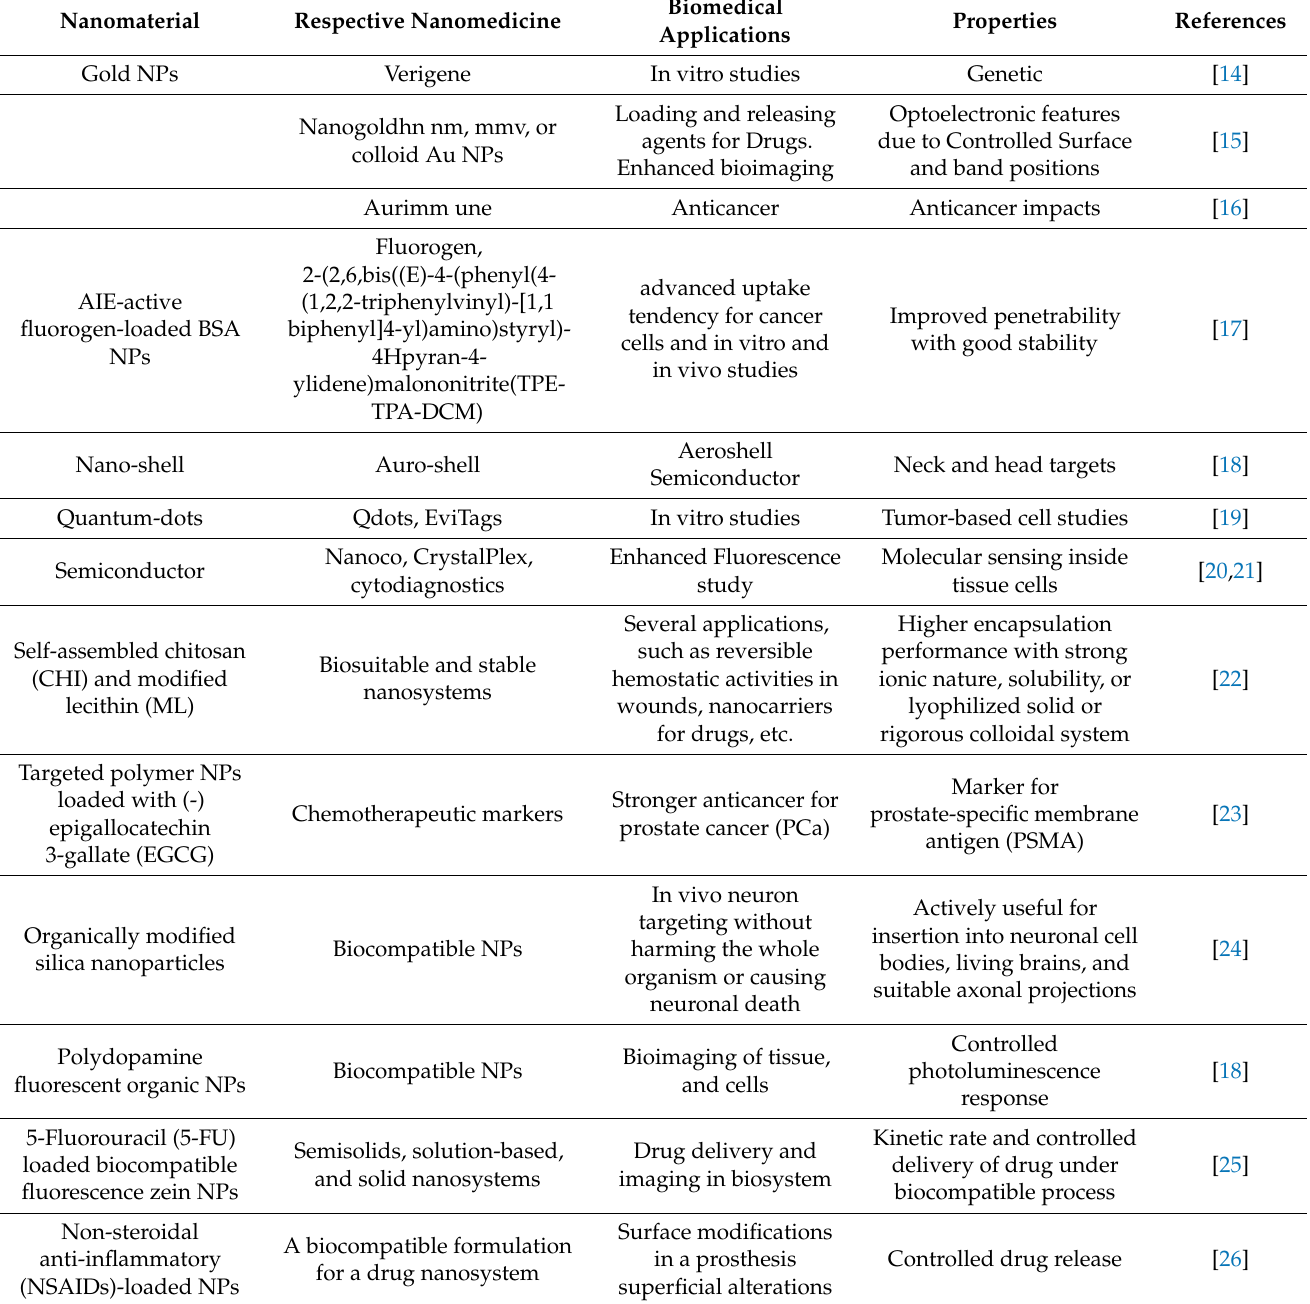
Table 2. Examples of biocompatible nanomaterials for healthcare